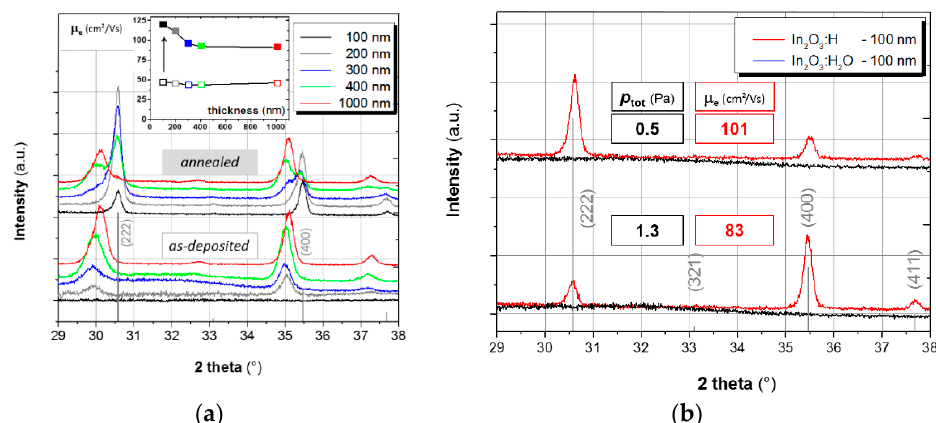
Figure 1. XRD patterns and Hall-mobility data for the RF sputtered In 2 O 3 :H films: ( a ) variation of thickness at p tot = 0.5 Pa; ( b ) variation of the sputtering pressure at a fixed film thickness. In all cases the as-deposited state (In 2 O 3 :H 2 O) is compared with the annealed one (In 2 O 3 :H). The cubic In 2 O 3 powder standard (ICDD Nr. 00-006-0416) is shown in grey bars.